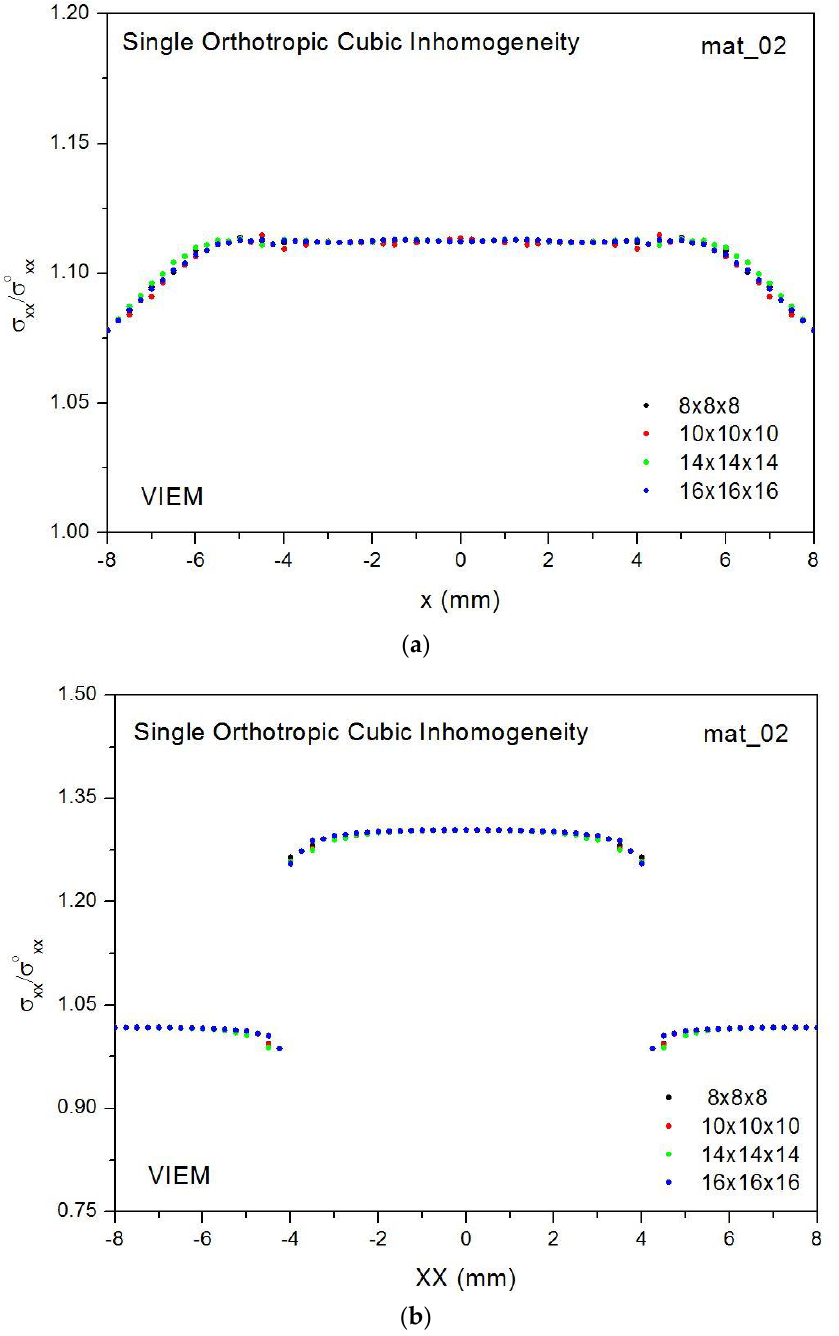
Figure 10. Numerical results using the volume integral equation method (VIEM) for the normalized tensile stress component (σ xx /σ oxx ) along the x-axis and the XX-axis (−8 mm ≤ x, XX ≤ 8 mm) for Model_8 × 8 × 8, Model_10 × 10 × 10, Model_14 × 14 × 14 and Model_16 × 16 × 16 under uniform remote tensile loading. ( a ) x-axis; ( b ) XX-axis.